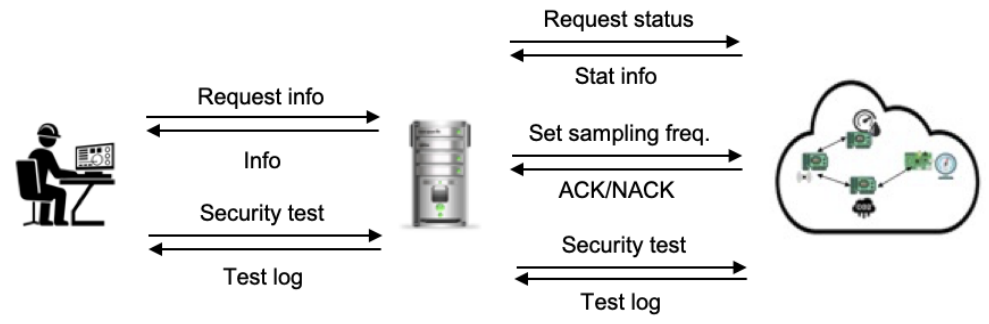
Figure 2. Interaction across